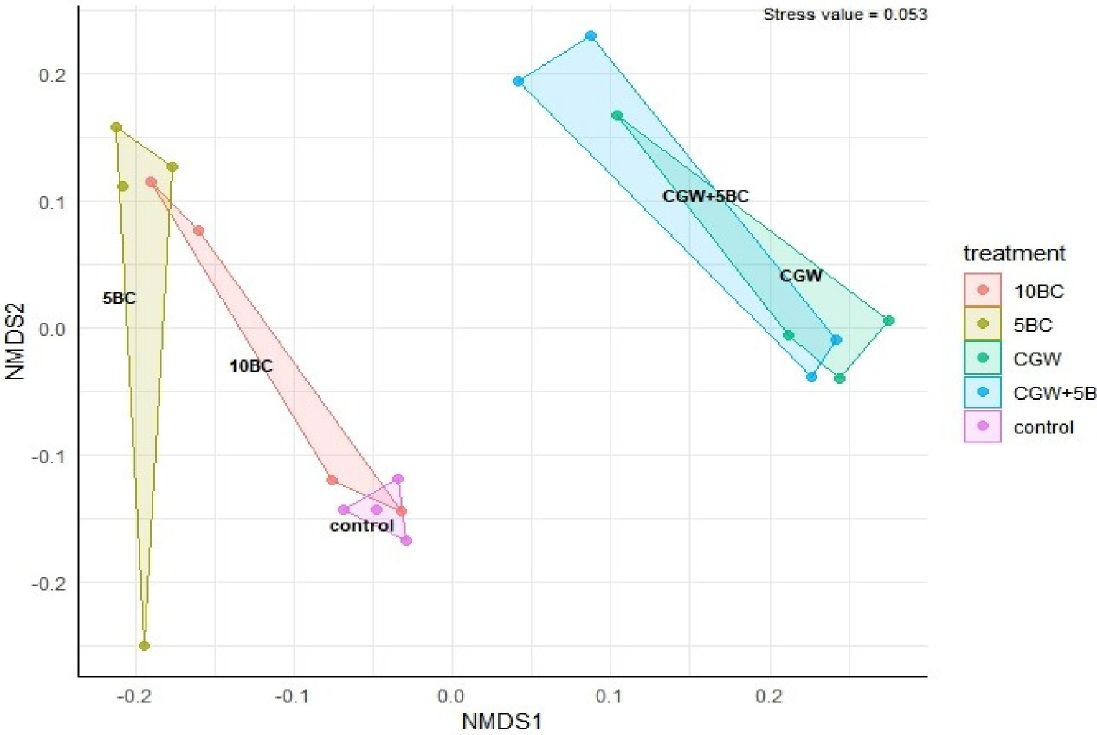
Fig 1. Nonmetric multidimensional scaling (NMDS) based on Bray-Curtis community dissimilarity revealed that bacterial/ archaeal community compositions in compost amended soils were most dissimilar to the unamended CK soil. Treatments include unamended control (CK), 12.5 t ha -1 biochar (B1), 25 t ha -1 biochar (B2), 5 centimeter (cm) green waste compost (CM), and 12.5 t ha -1 biochar and 5 cm compost (B1+CM).